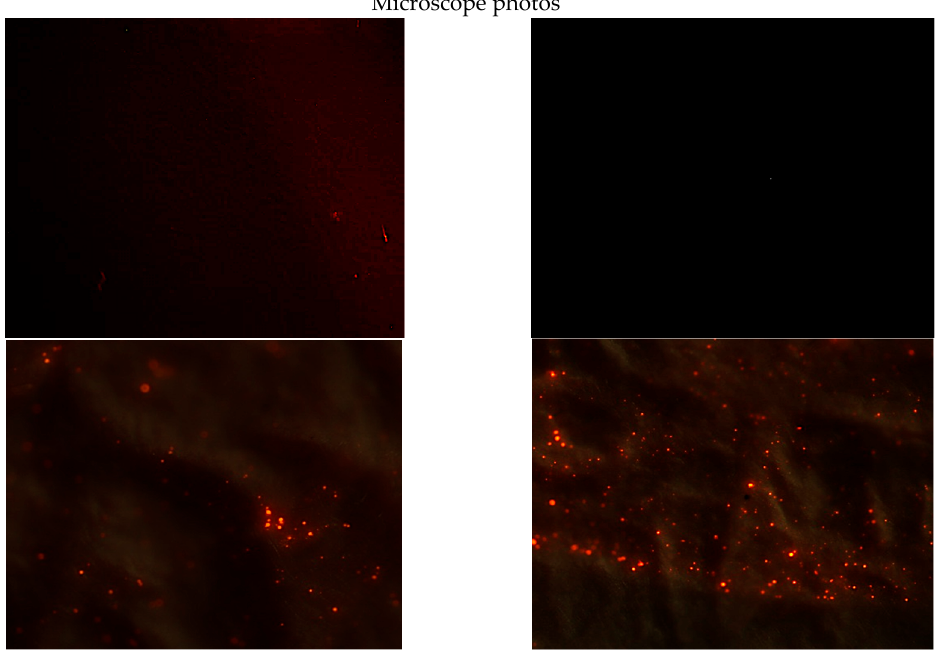
Figure 3. Polyurethane microplastics (PU-MPs) present in C. riparius four instar larvae digestive tract after a 10-day exposure to 0 (control condition, two random filters) and 375 mg PU-MP/kg of sediment (two random filters). Particles presenting red fluorescence are PU-MPs. Note: The presence of MPs in controls might be due to potential airborne contamination. Nonetheless, the number of particles was negligible compared to PU-MP treatments. Eyepiece magnification: × 10; Objective: ×